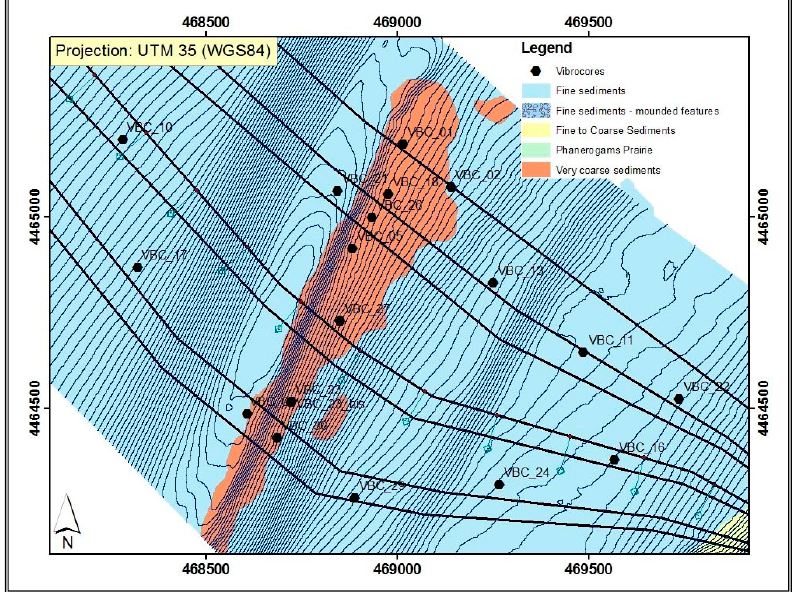
Figure 11. Shallow geology model, Asia Side for Lâpseki–Sütlüce I.